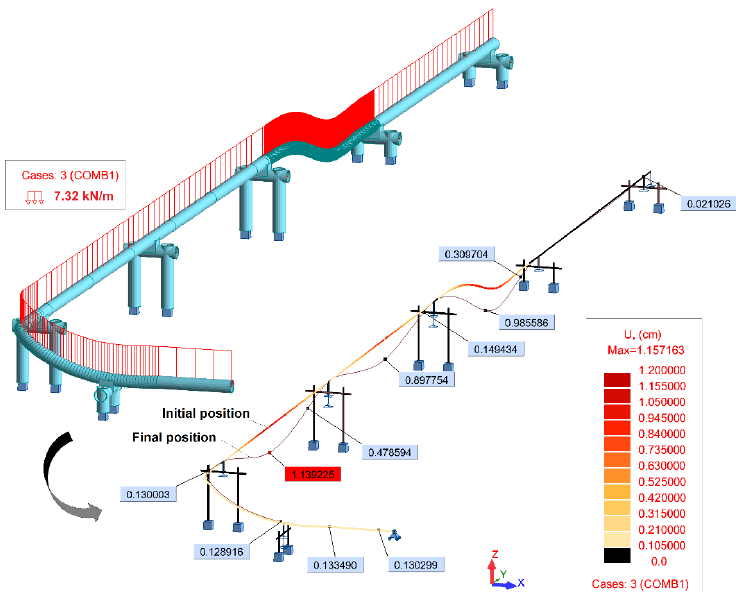
Figure 4. Maximum displacement achieved for permanent loads (ULS1) during normal conditions.